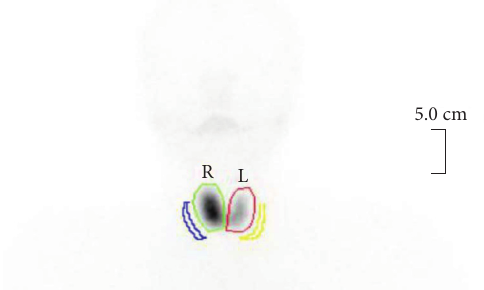
Figure 1: TC-99 THYROID SCINTIGRAPHY demonstrating moderate, asymmetrical enlargement of the thyroid gland, with a larger right lobe. Additionally, the right lobe demonstrates more radiotracer uptake, keeping with unilateral Grave’s